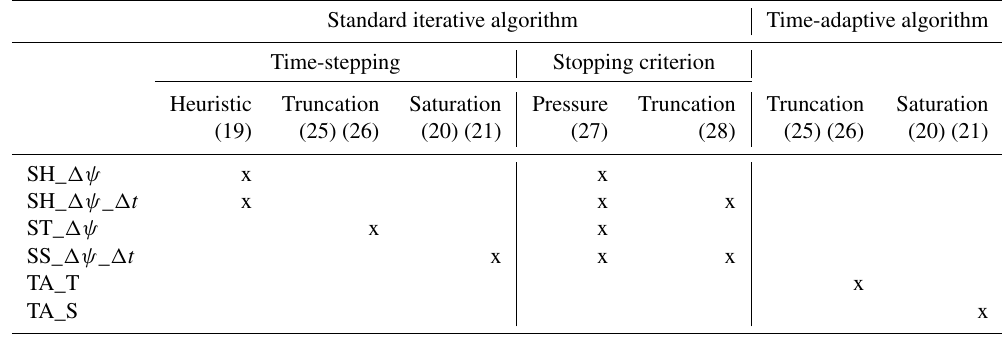
Table 1. Different options of the tested algorithms. Reference to the corresponding equation in parentheses. Standard iterative algorithm